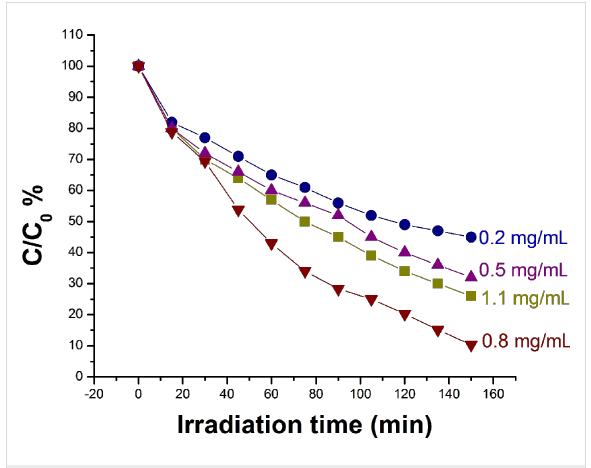
Figure 12: Effect of dye concentration on photocatalytic